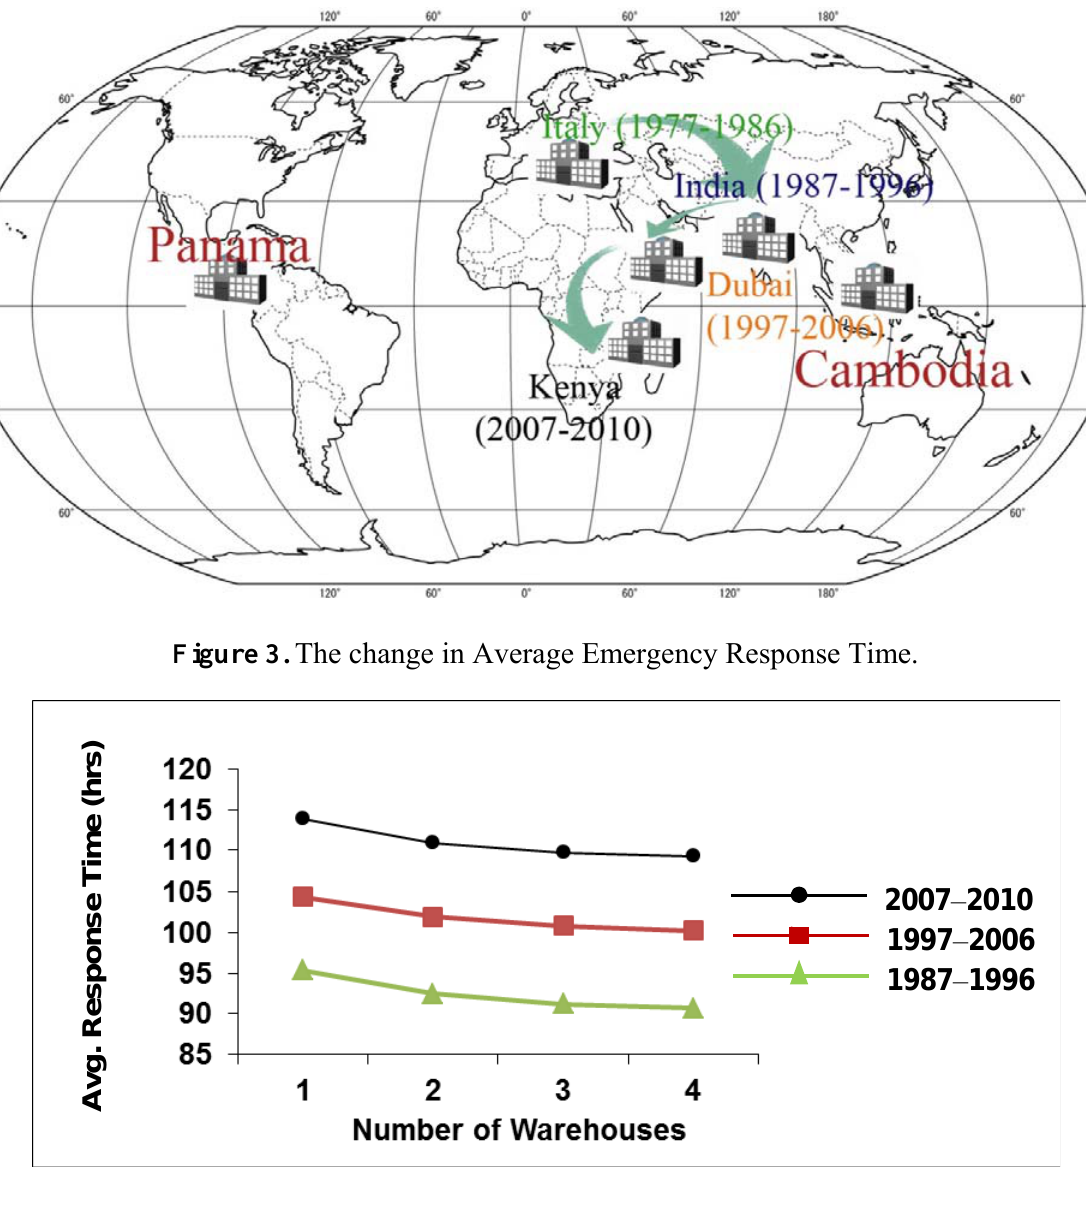
Figure 2. The change in location of the third warehouse with respect to decades.